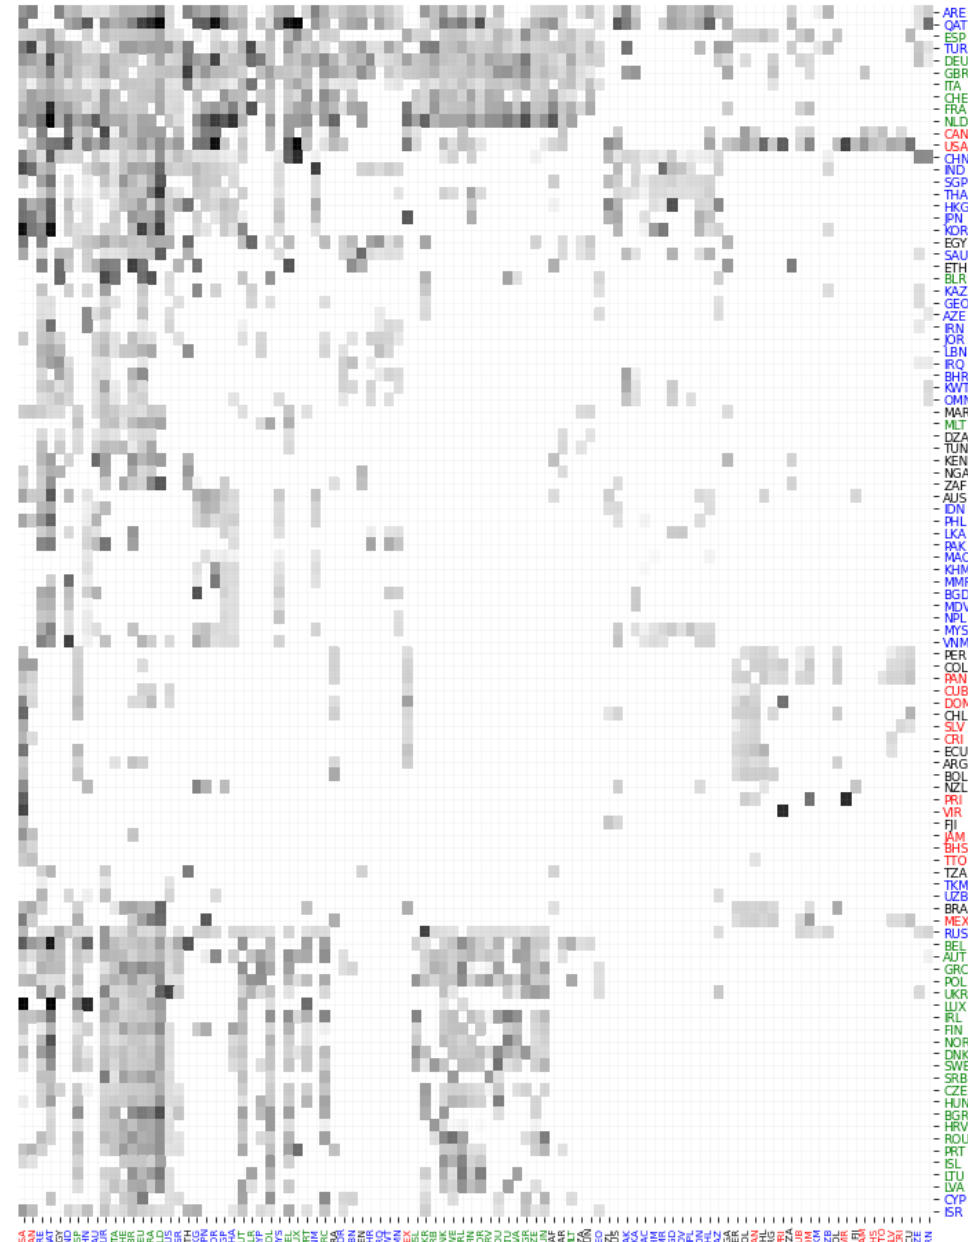
Figure 9. Heatmap and clustering for all country